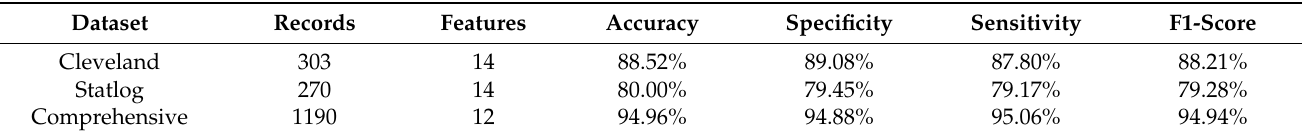
Table 5. The Bi-LSTM model performance analysis.